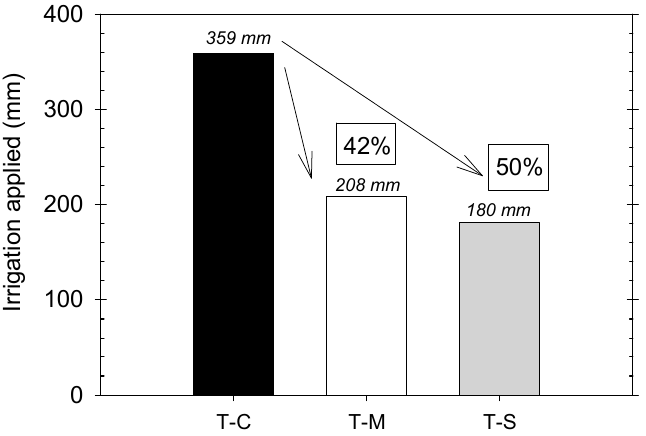
Figure 1. Irrigation applied (mm) during the postharvest period (May to October) in the different irrigation treatments. Percentage with respect to the Control treatment. (T–C). Moderate water deficit treatment (T–M); Severe water deficit treatment (T–S).